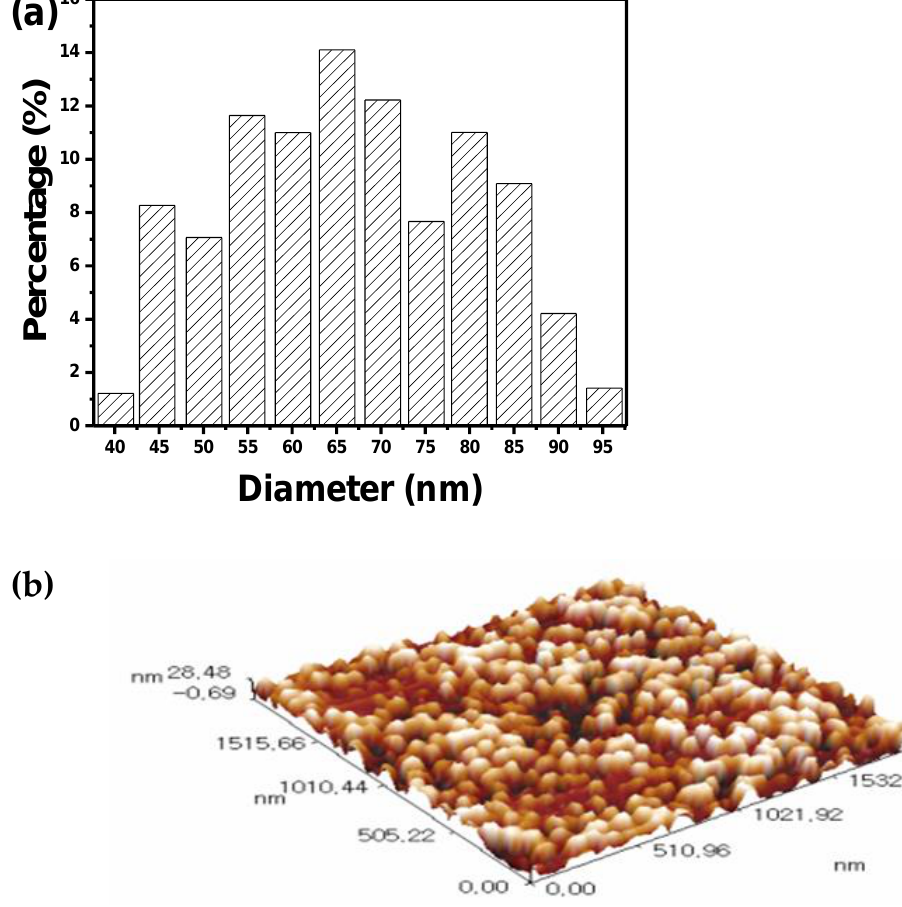
Figure 2. ( a ) Granularity cumulation distribution chart, and ( b ) AFM analysis images of cement particles used in the work.